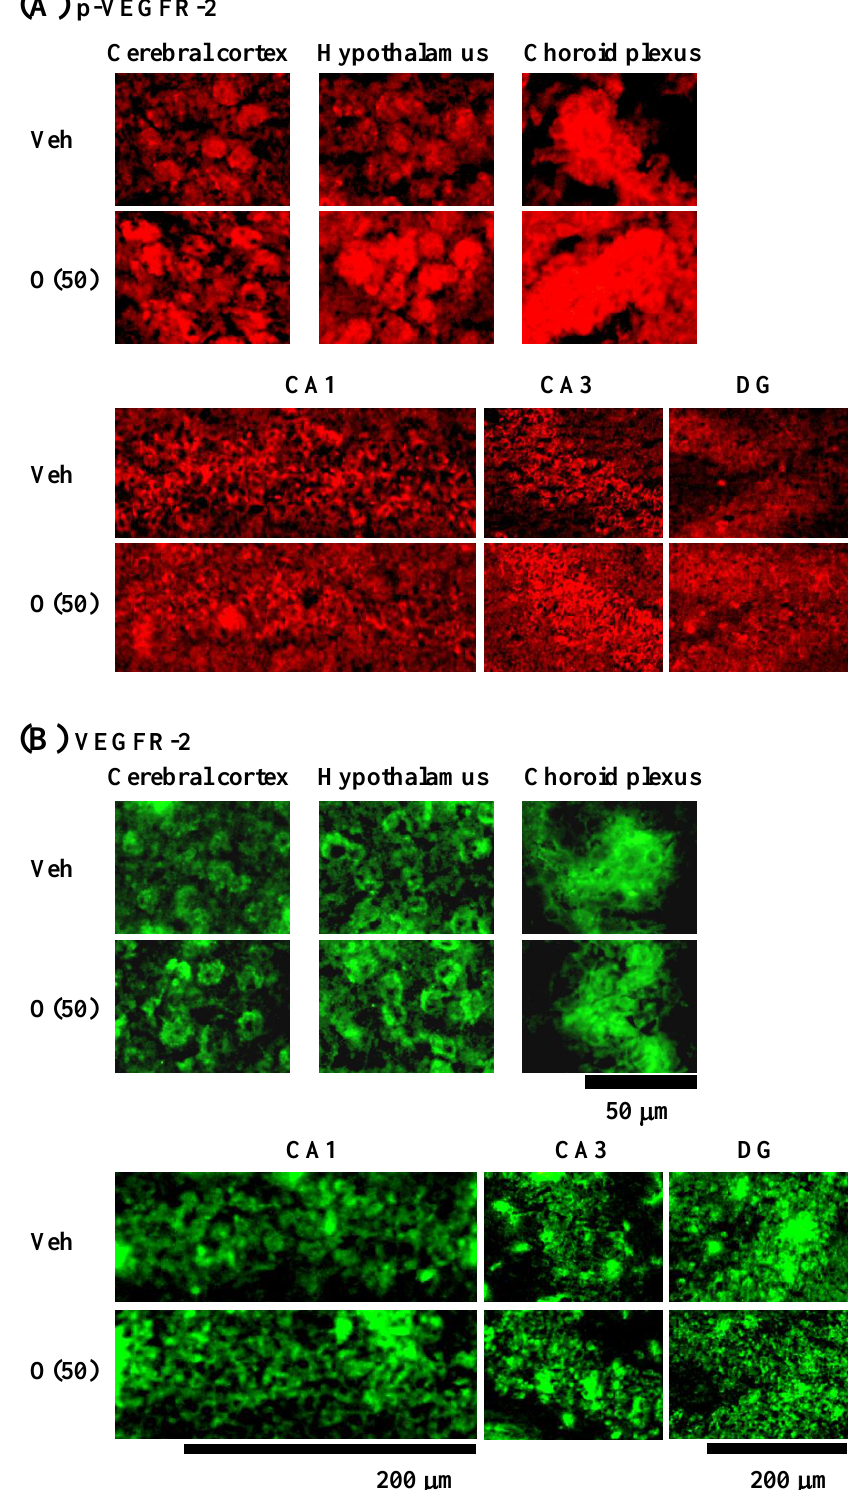
Figure 10. Effects of oligomers on p-VEGFR-2 and VEGFR-2 expression in various brain regions. Fifty-nine-week-old SAMP8 were administered vehicle (Veh, water p.o., n = 3) or oligomers (O (50), 50 mg/kg B.W./day, p.o., n = 3). After seven days of administration, brain slices were immunostained with p-VEGFR-2 ( A ) and VEGFR-2 ( B )